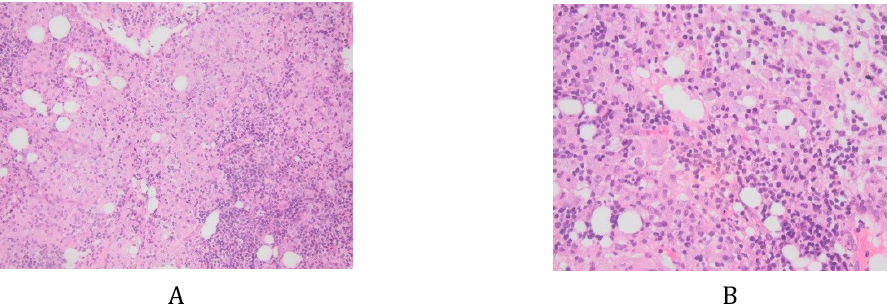
Figure 3. Histiocytes with clear foamy cytoplasm. A: hematoxylin and eosin (HE) stain, ×10; B: HE,